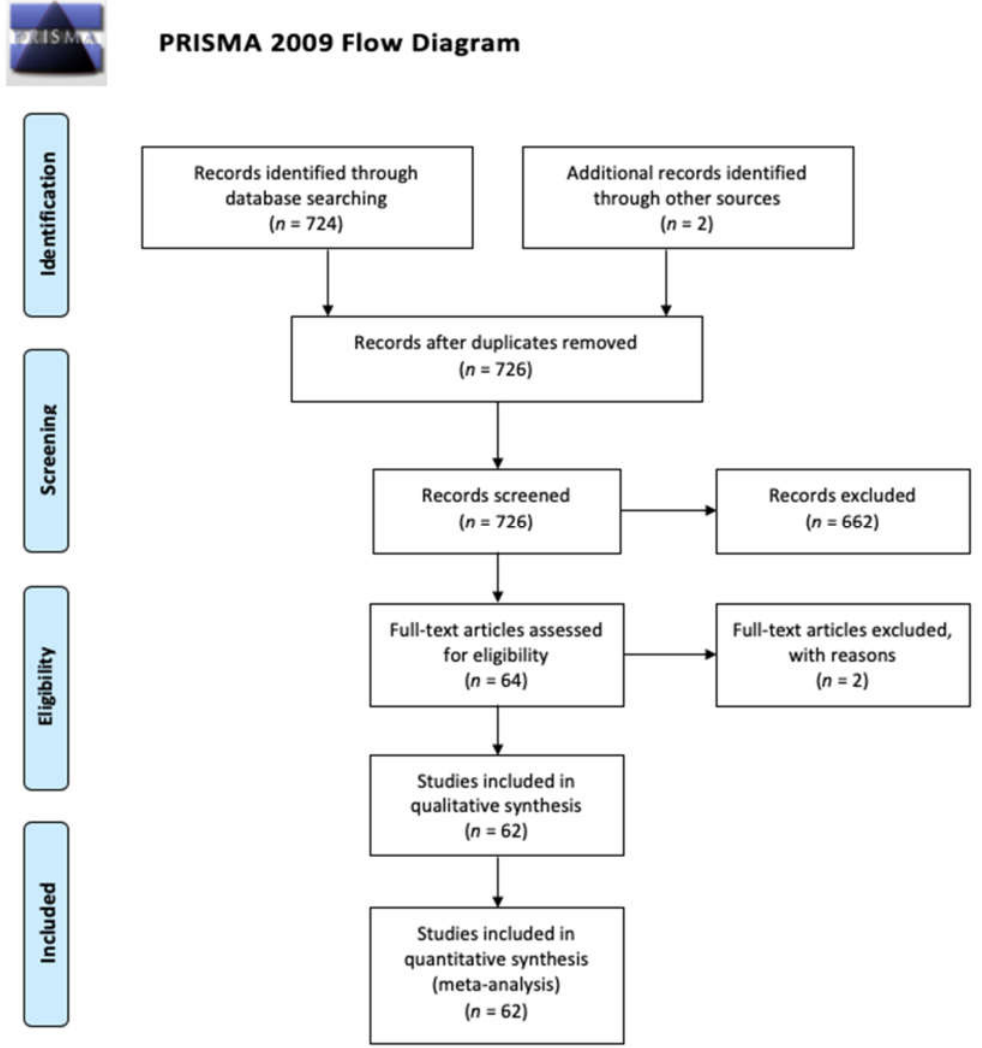
Figure 2. Preferred Reporting Items for Systematic Reviews and Meta-Analyses (PRISMA) 2009 flow diagram.